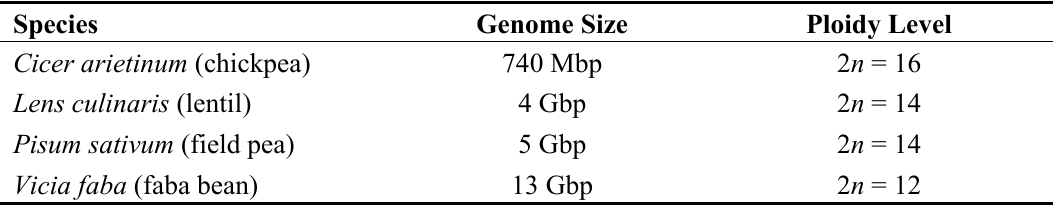
Table 2. Summary of genome sizes and ploidy level of cool season food